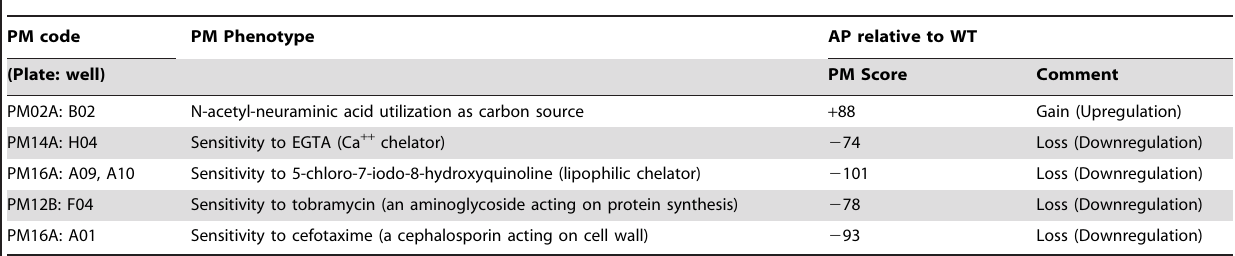
Table 1. PM array